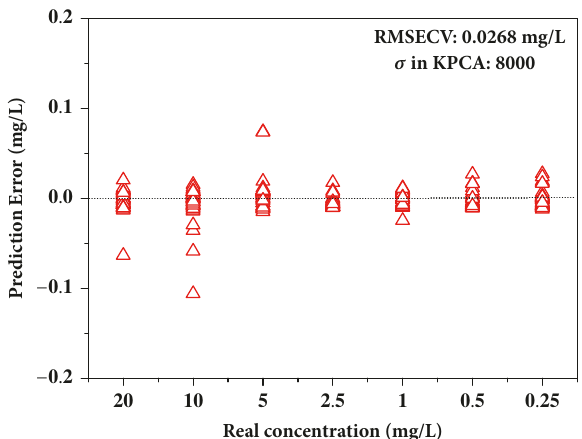
Figure 6: Predicted error of the optimal model built using SVR and KPCA with 𝜎 of 8000.